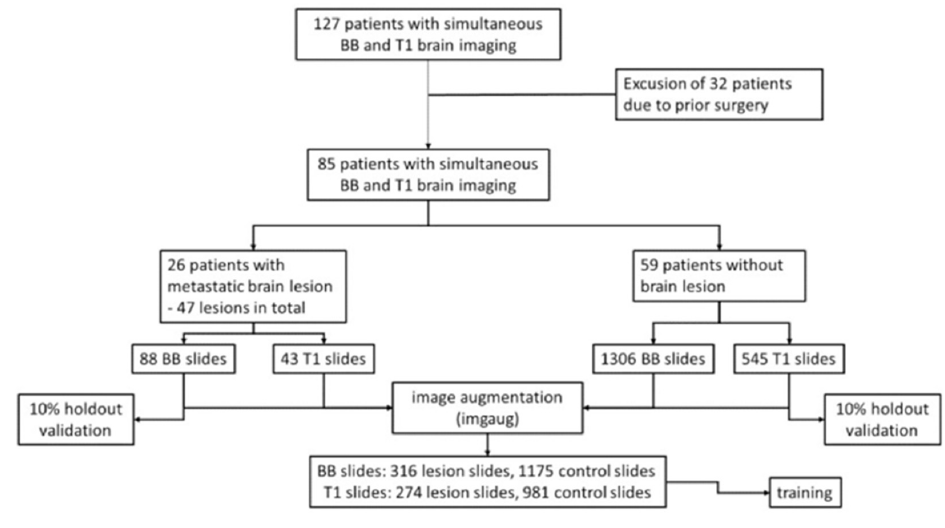
Figure 3. Flow chart for patient selection and split of the data